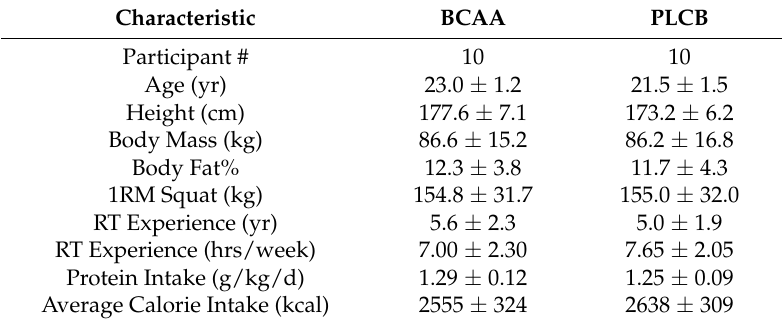
Table 1. Participant